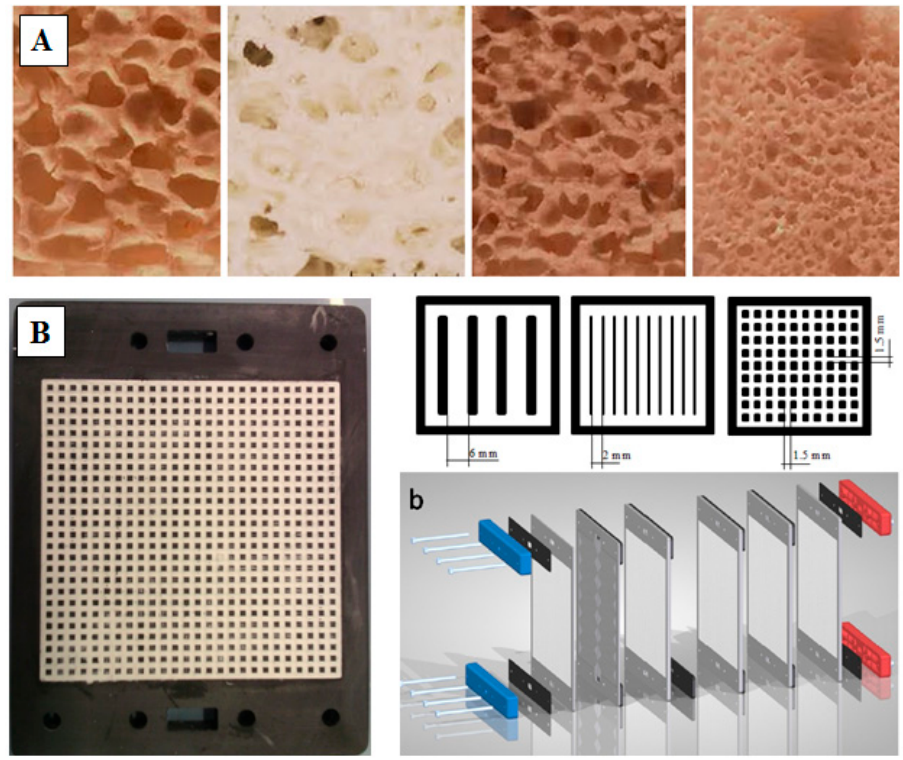
Figure 8. Zeolite–siloxane composite foams at varying filler contents ( A ); modular graphite heat exchange adsorber [63] ( B ).